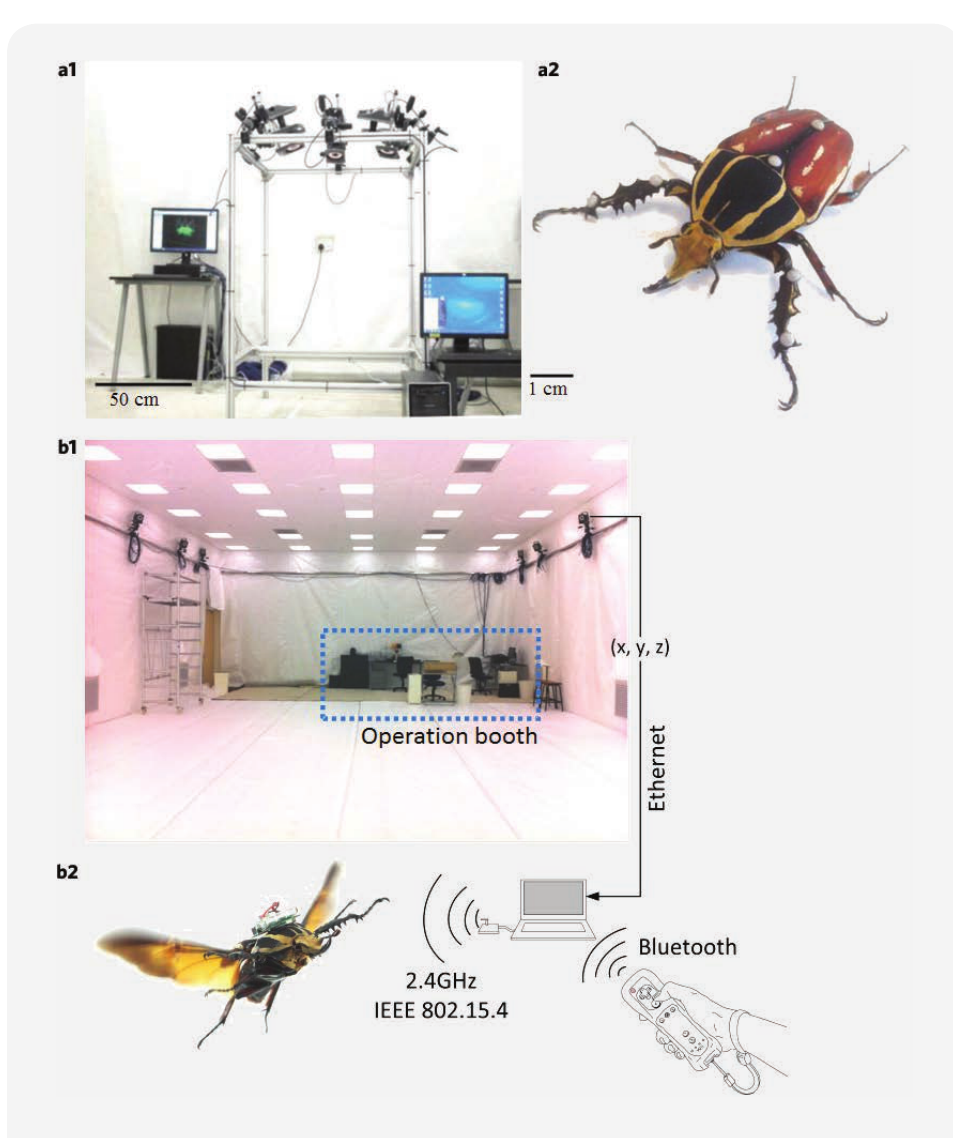
Figure 2. Motion capture system for studying insect locomotion. (a1) A motion capture system with six VICON cameras to investigate a beetle’s walking gait investigation. The system can reconstruct and export the three-dimensional coordinates of retro-refl ective markers. (a2) Six retro-refl ective markers were attached onto a beetle, two markers on each foreleg to capture the movement of the tibia segments and two additional markers on the back to capture the body orientation. (b1) A motion capture system with 18 VICON cameras was equipped in a fl ight capture room (9 m × 16 m × 4 m). (b2) A beetle with a tiny backpack could fl y freely around the room. Commanded by a Wii remote controller, the backpack applies an electrical stimulation to the beetle. The battery of the backpack was wrapped in retro-refl ective tape, which enabled three-dimensional trajectory tracking of the fl ying